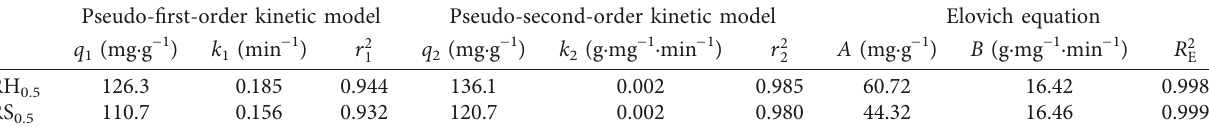
Table 4: Adsorption kinetic parameters. Pseudo-first-order kinetic model